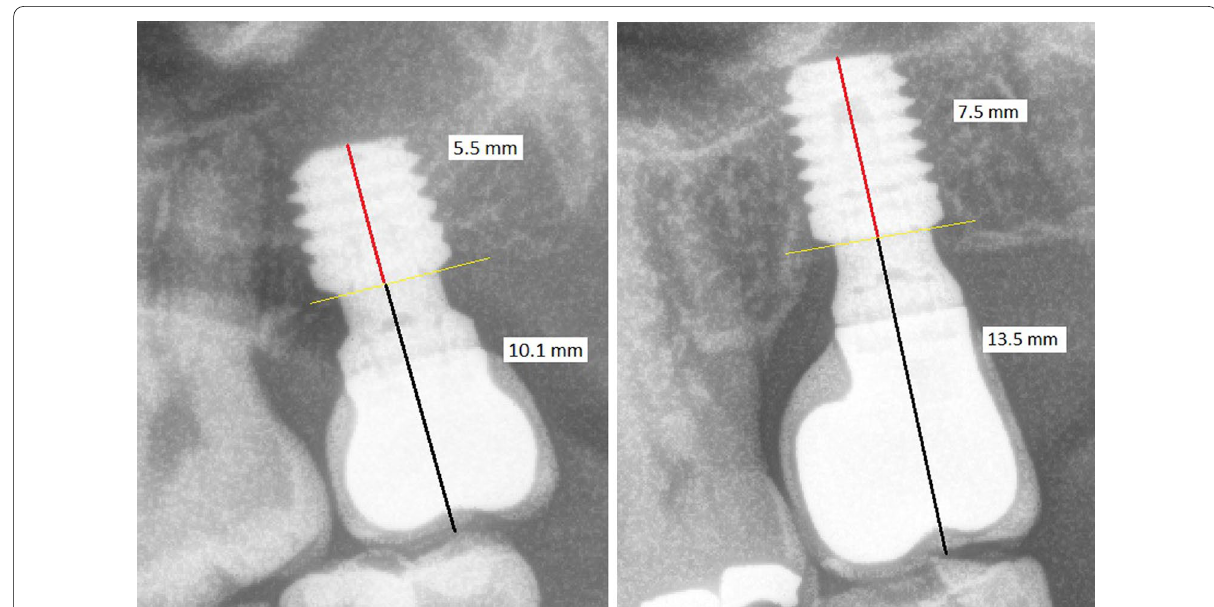
Fig. 4 Left : 5.5 mm length implant placed in the #2.7 position. Screw-retained single-crown over a 3 mm transepithelial (intermediate abutment). Crown-to-implant ratio: 1.84. Right : 7.5 mm length implant placed in the same position (#2.7). Screw-retained single-crown over a 3 mm transepithelial (intermediate abutment). Crown-to-implant ratio: 1.80